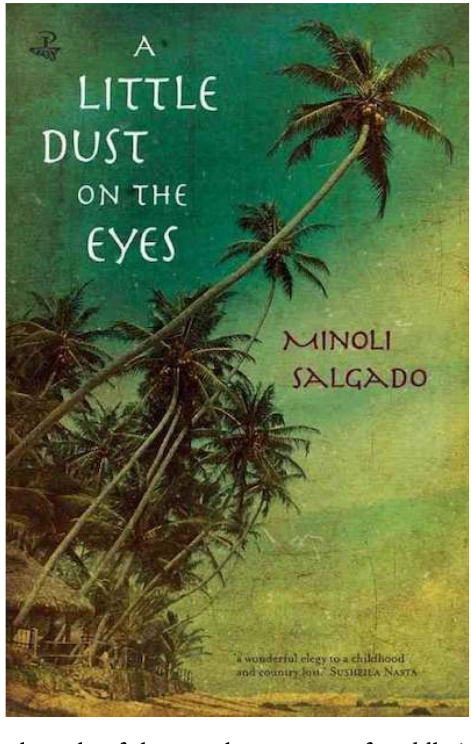
Figure 4. Cover of A Little Dust in the Eye by Minoli